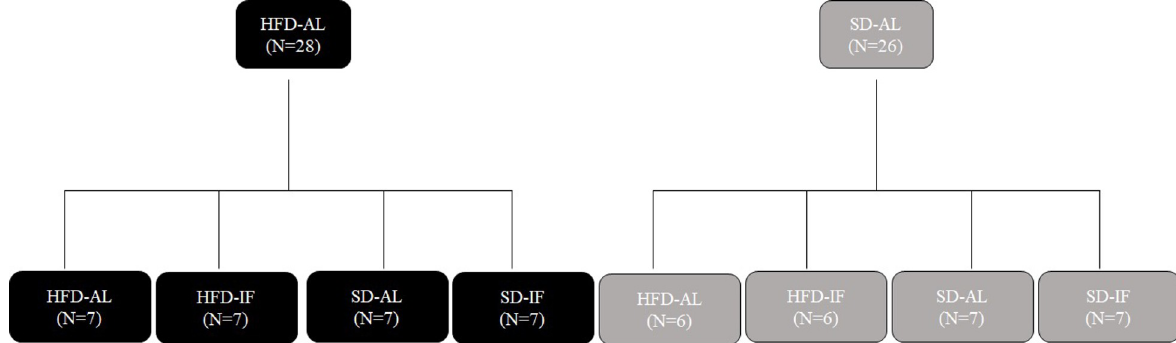
Fig 1. Illustrates the groups and their treatments. High-fat diet (HFD); Standard diet (SD); Intermittent fasting (IF); Ad libitum